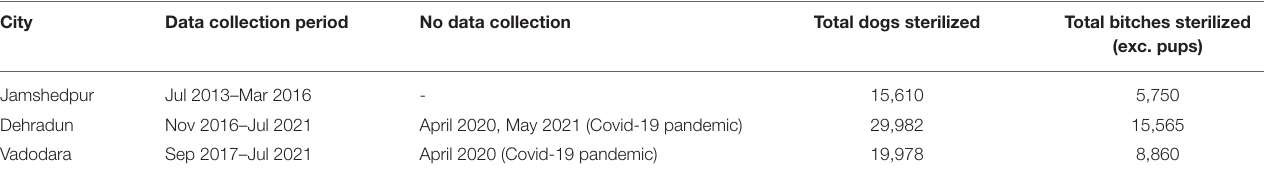
TABLE 1 | Data collection periods and total clinic sterilization counts in the Indian cities Jamshedpur, Dehradun, and Vadodara. Fifteen and seven dogs of unrecorded sex and age were excluded from the Jamshedpur and Dehradun datasets, respectively. City Data collection period No data collection Total dogs sterilized Total bitches sterilized